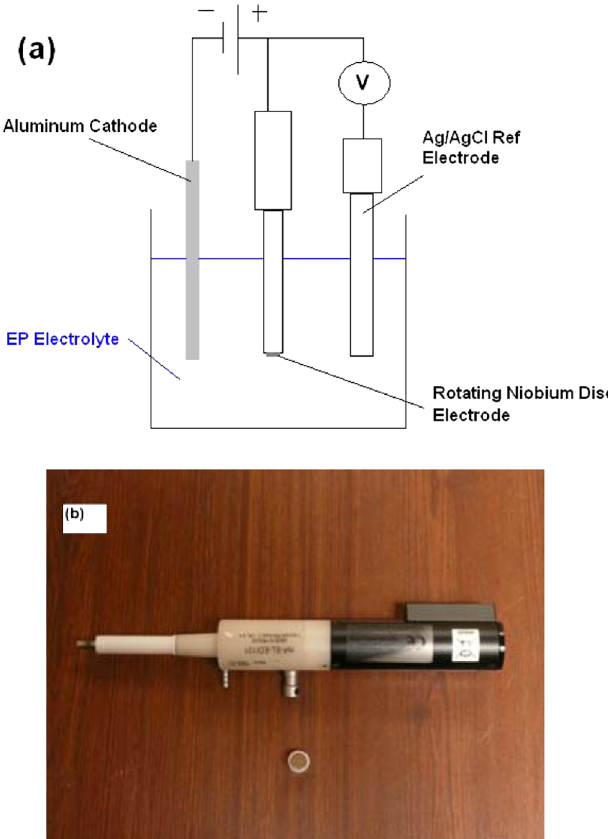
FIG. 1. (Color) (a) Setup with three electrodes used (top) and (b) picture of the rotating system for the disk sample